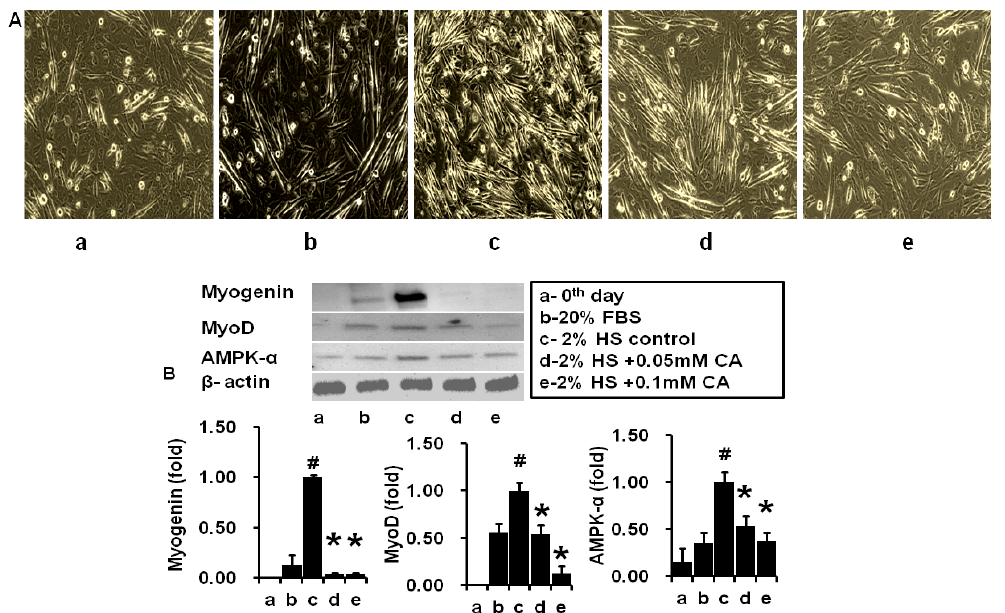
Figure 3. Impact of coumaric acid on myoblast formation and myogenic markers. ( A ) microscopic views of myoblast differentiation in experimental cells; ( B ) Western blot analysis of Myogenin, MyoD and AMPK- α (AMP activated protein kinase-alpha) expression in experimental cells (a—day 0; b—20% FBS; c—2% HS (Horse serum; d—2% HS + 0.05 mM CA; e—2% HS + 0.1 mM CA). The results represent the mean ± SEM of three replicates. # p < 0.05 level significance as compared to day 0 and 20% FBS (Bovine fetal serum) supplemented cells; * p < 0.05 level significance as compared to control cells.